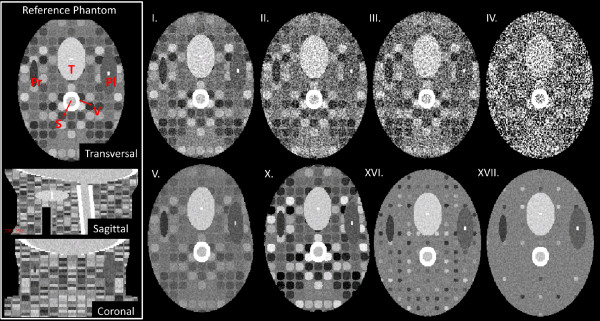
A selection of the synthetically generated “head-and-neck” phantoms as used in this study. A transversal, sagittal and coronal cross-section of the reference phantom is shown within the white box. Abbreviations of the simulated structures: T = tumour; V = vertebrae; Pl = parotid left; Pr = parotid right; S = spinal cord. Phantoms I-IV have similar properties as the reference phantom but with varying noise levels (1SD noise = ± 40, ± 80, ± 100, and ± 200 HU, respectively). Simulated deformed phantom images are shown by V and X (with grey-value factor of 0.5 and 1.5, respectively). Phantoms XVI and XVII vary in disc spacing (7.0 and 19.0 mm, respectively) from the reference situation (1.0 mm). The properties of all phantoms are listed in Table 1.